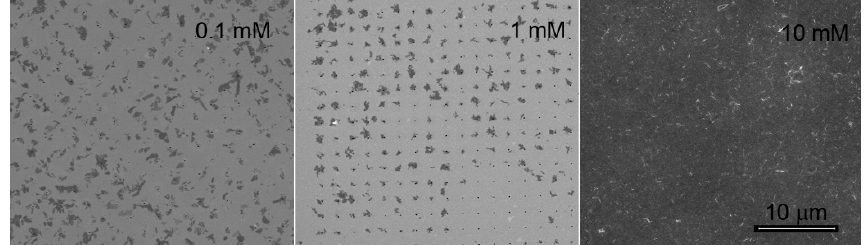
Figure 3. EPD of WS 2 suspended in PBS at different concentrations.